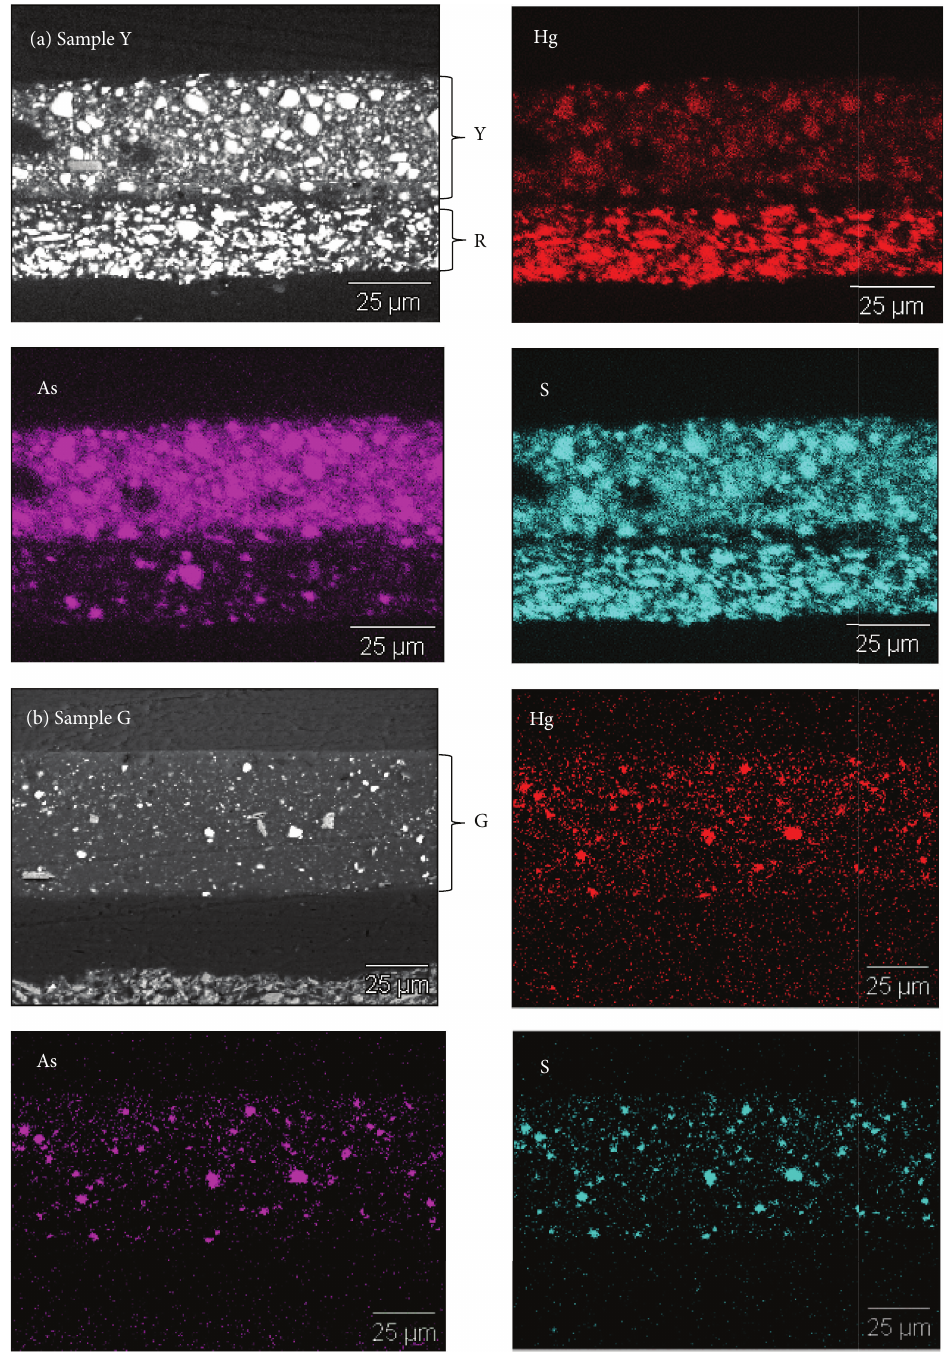
Figure 5: Cross-sectional element mapping experiments. (a) Sample Y, (b) Sample